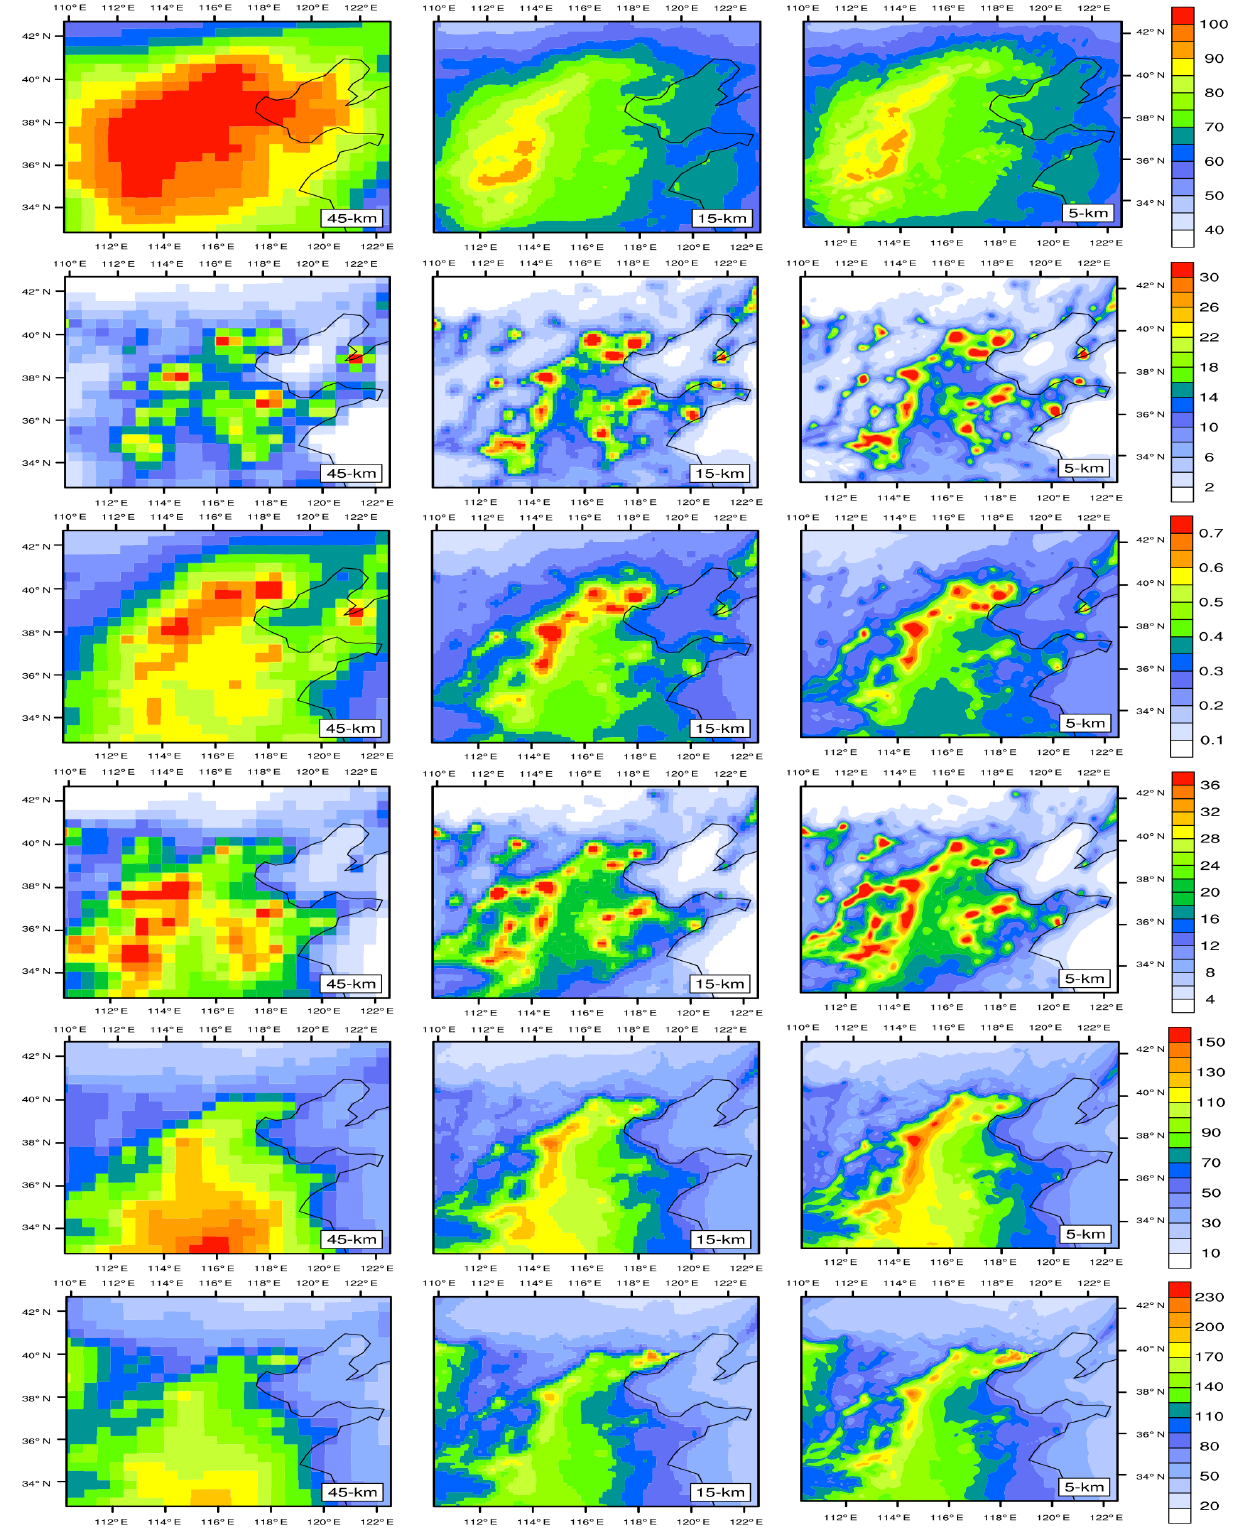
Figure 7. Simulated January (SO 2 , PM 2 . 5 , and PM 10 ) and July (O 3 , NO x , and CO) surface average air quality from the three grids: first row is O 3 (ppbv); second row is NO x (ppbv); third row is CO (ppmv); fourth row is SO 2 (ppbv); fifth row is PM 2 . 5 (µgm − 3 ); sixth row is PM 10 (µgm − 3